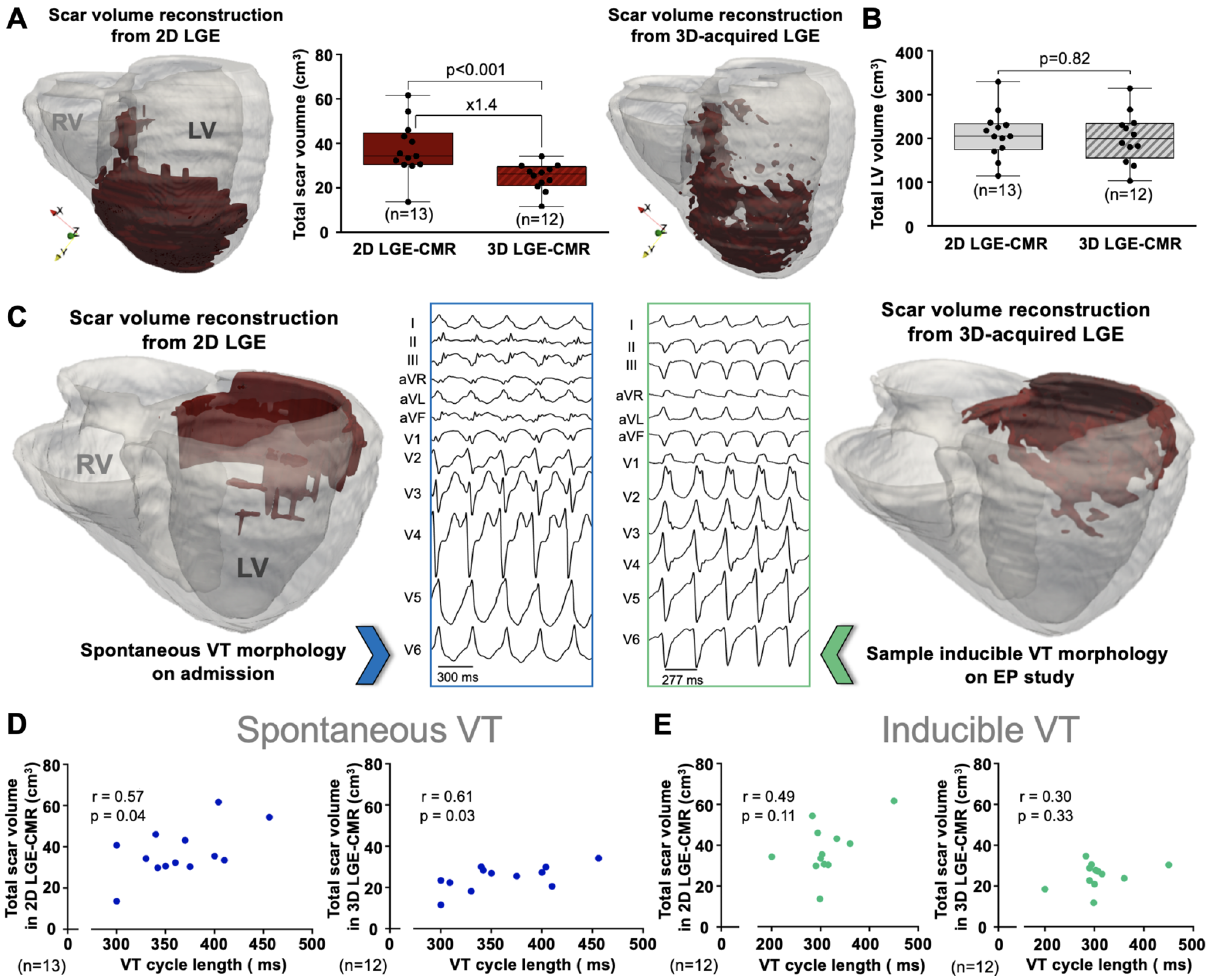
Figure 5. Patient-specific scar volume reconstruction and correlation analysis with the cycle length of ventricular tachycardia episodes. ( A ) Scar volume comparisons between 3D- and 2D-LGE-CMR reconstructions. ( B ) Left ventricular (LV) myocardial volume comparisons between 3D- and 2D-LGE-CMR reconstructions. ( C ) Representative case of 2D- and 3D-LGE-CMR scar reconstructions and the associated ventricular tachycardia (VT) episodes on admission and during the electrophysiological (EP) study. ( D , E ) correlation analysis between the cycle length of spontaneous ( D ) /inducible ( E ) VT episodes and scar volumes from 3D ( D ) and 2D-LGE-CMR ( E ) reconstructions. RV: right